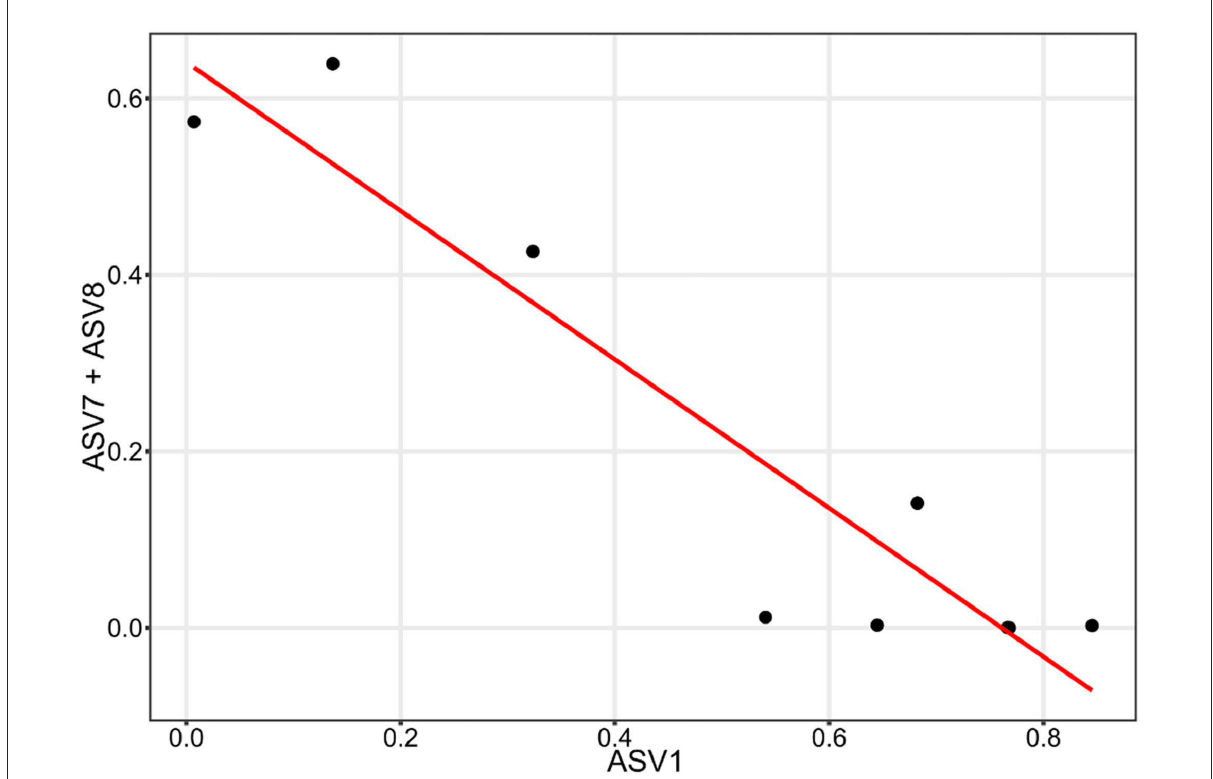
FIGURE7 Linear correlation between the abundance of ASV1 and the combined abundance of ASV7 and ASV8.